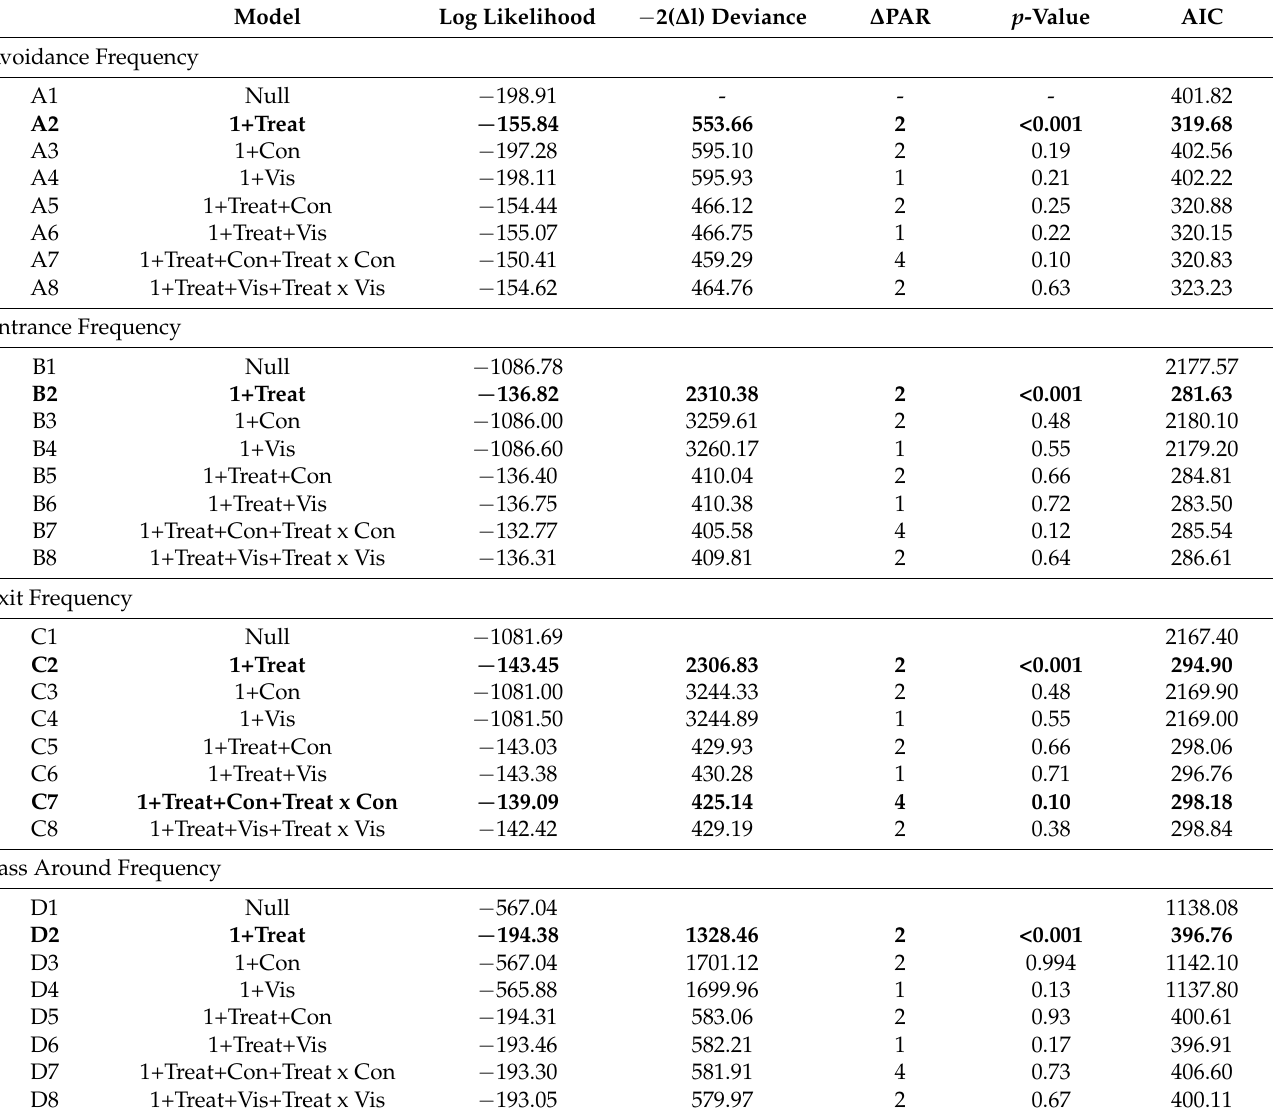
Table 2. Statistical results from the mixed effect models on bull shark ( Carcharchinus leucas ) behavior. Trial (R) is treated as a random effect. Others are treated as fixed effects: Treat (treatment), Con (conspecific density), and Vis (water visibility). Selected models for avoidance, entrance, exit, and pass around frequencies were A2, B2, C2, and D2, respectively, based on a combination of Akaike Information Criteria (AIC), and behavior of the residuals of a model using a quantile–quantile (Q–Q) plot, and associated P-values. Significant models for main effects ( p ≤ 0.05) and interaction terms ( p ≤ 0.1) are in bold. Abbreviations: 1 = y -axis intercept, ∆ l = change in log likelihood value between former model and model being considered, ∆ PAR = change in degrees of freedom between former model and model being considered, P-value = the level of significance of the explanatory variable added, AIC = Akaike Information Criterion (2 x (log likelihood) + 2 x number of parameters), a model selection criterion.